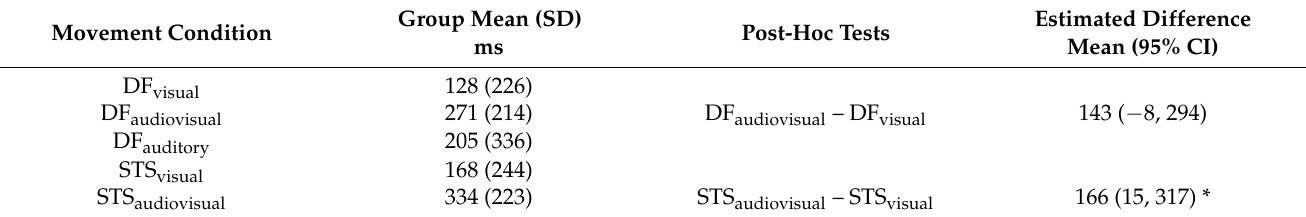
Table 1. Descriptive statistics and pairwise comparisons for PN latency.